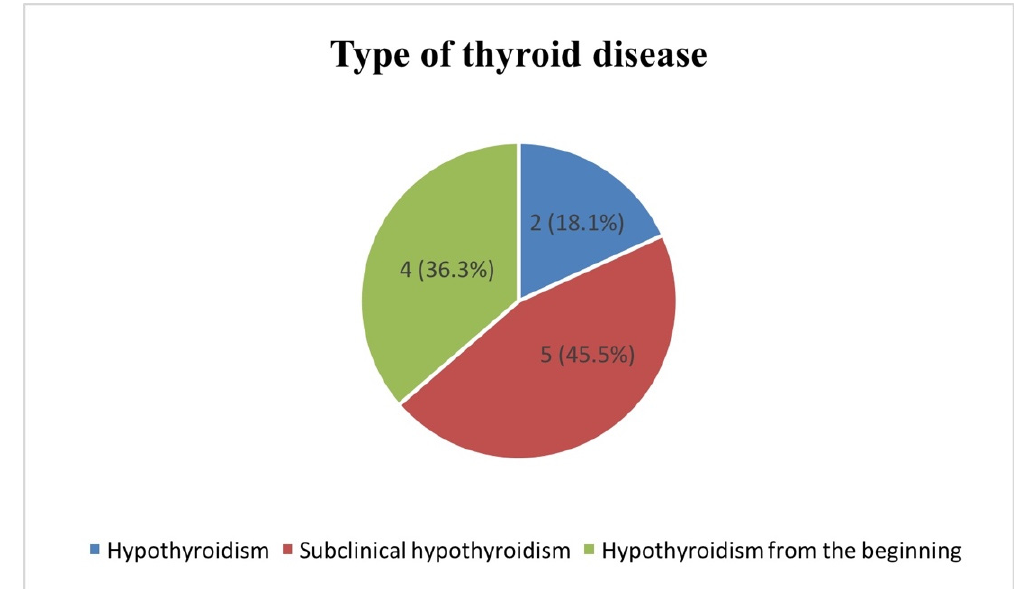
Figure 2. Types of thyroid disorders.